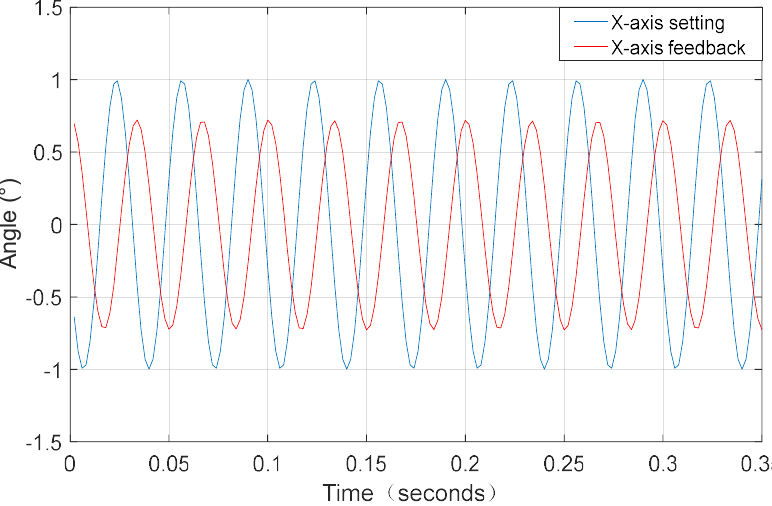
Figure 9. Response bandwidth test after decoupling given a 300 Hz sinusoidal on the X-axis. In addition, a phase difference test of FSM was carried out by using a sinusoidal curve with a 200 Hz frequency, an amplitude of 1.0 mrad, and a phase difference of 180 the X-axis and Y-axis. In Figure 10, the position feedback waveform collected by feedback at 10 kHz is shown. The test waveform shows that the phase difference of X/Y-axis has no effect on the movement of each degree of freedom of the FSM.